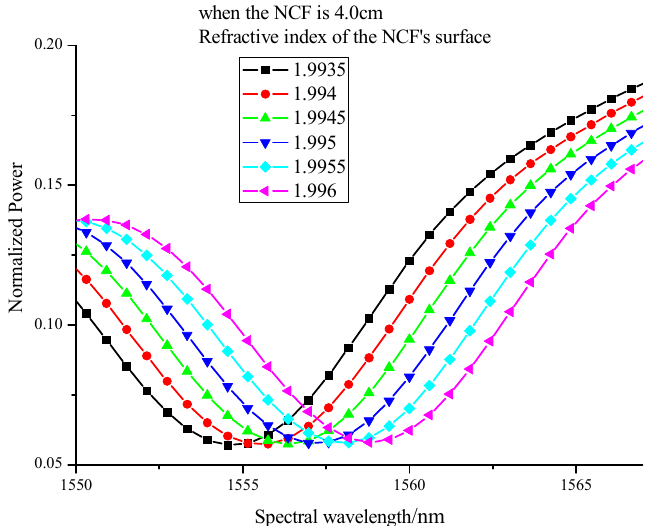
Figure 4. Resonant spectra of interferometer under different refractive indices when the length of NCF is 4 cm.